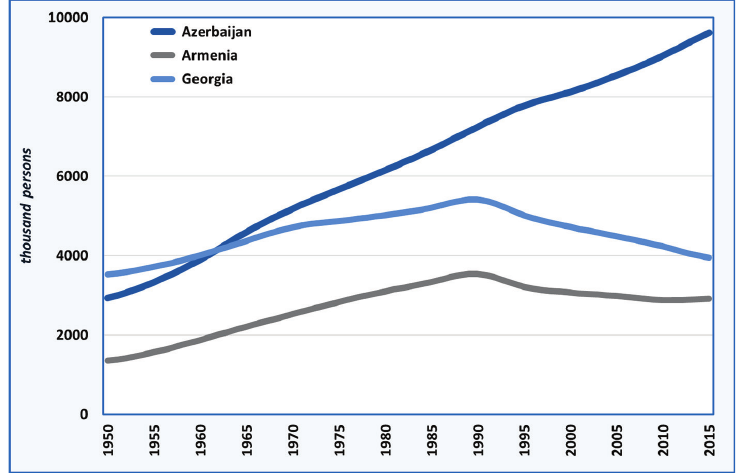
Figure 1. Population size in South Caucasus countries, 1990-2015. Source: based on UN Population Prospects (medium variant) data (UN Population